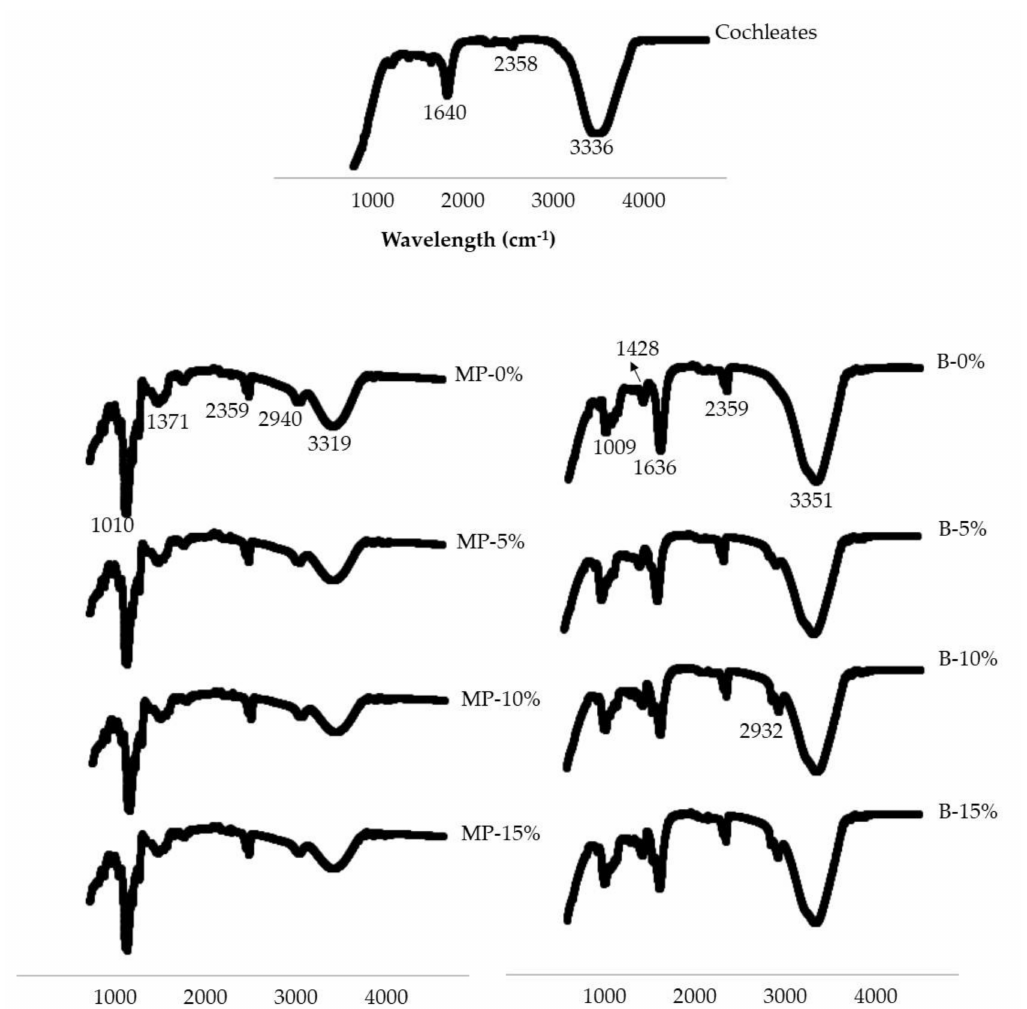
Figure 5. FTIR of cochleates of S . Infantis, microparticles (MP) and beads (B) with different concentrations of cochleates of S . Infantis (0–15%